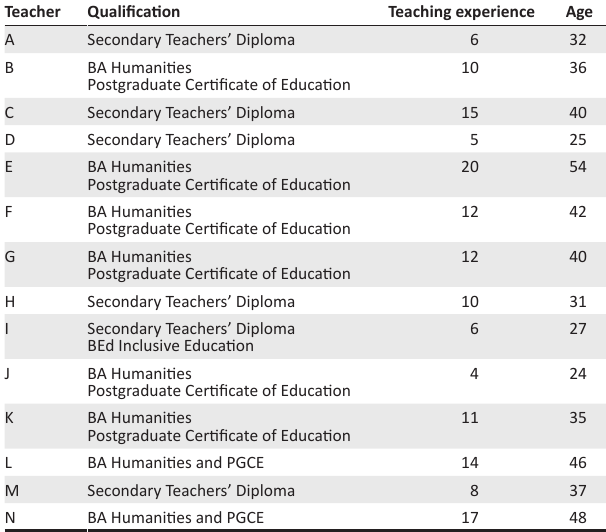
TABLE 1: Profile of teachers.